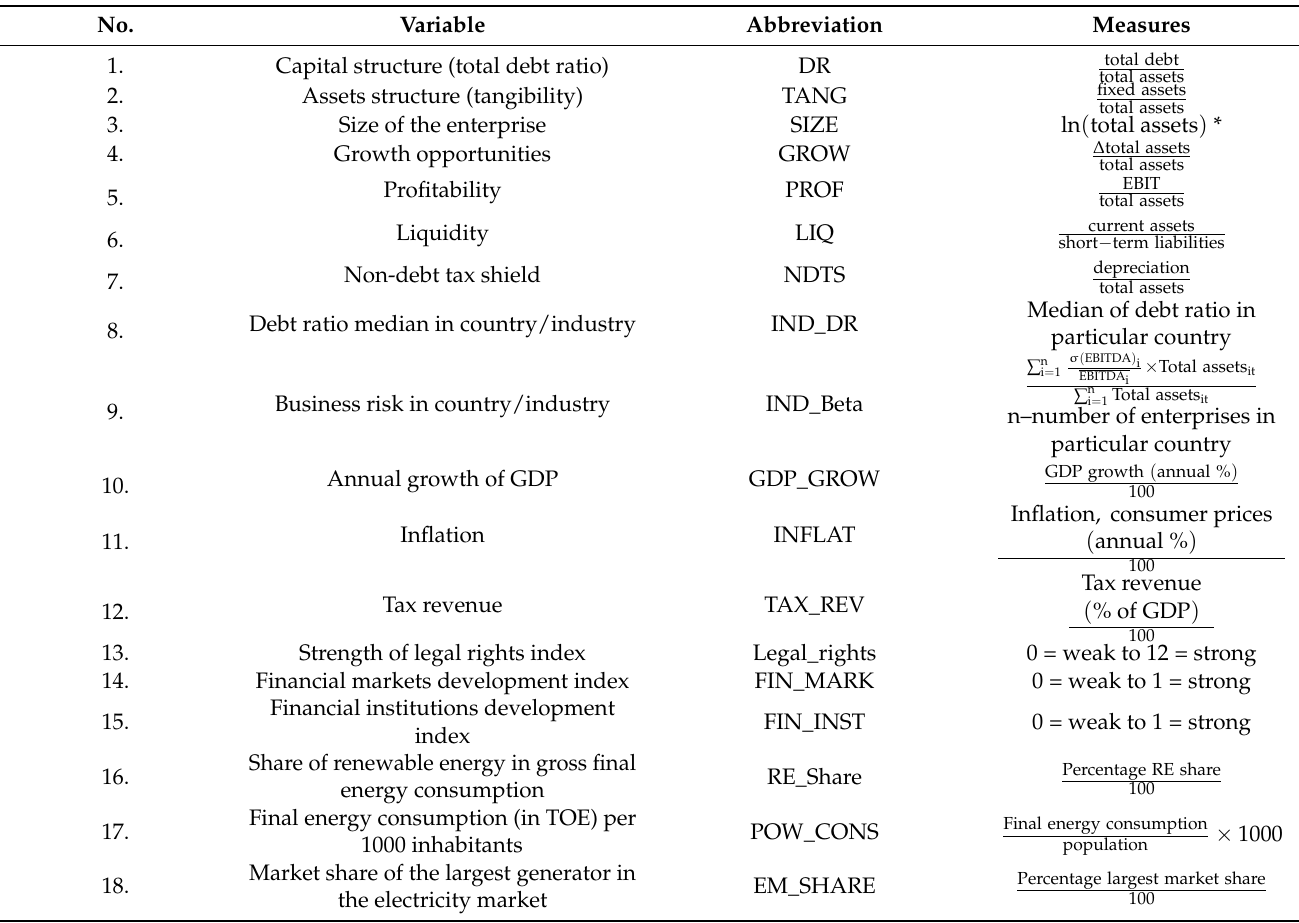
Table 1. Variables applied in the